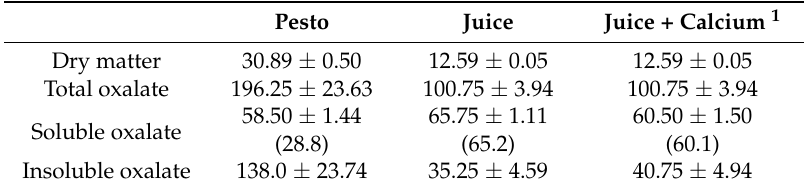
Table 4. Dry matter, total, soluble, and insoluble oxalate contents of pesto (mg/100 g WM) and juice (g/100 g juice) made from raw fat hen